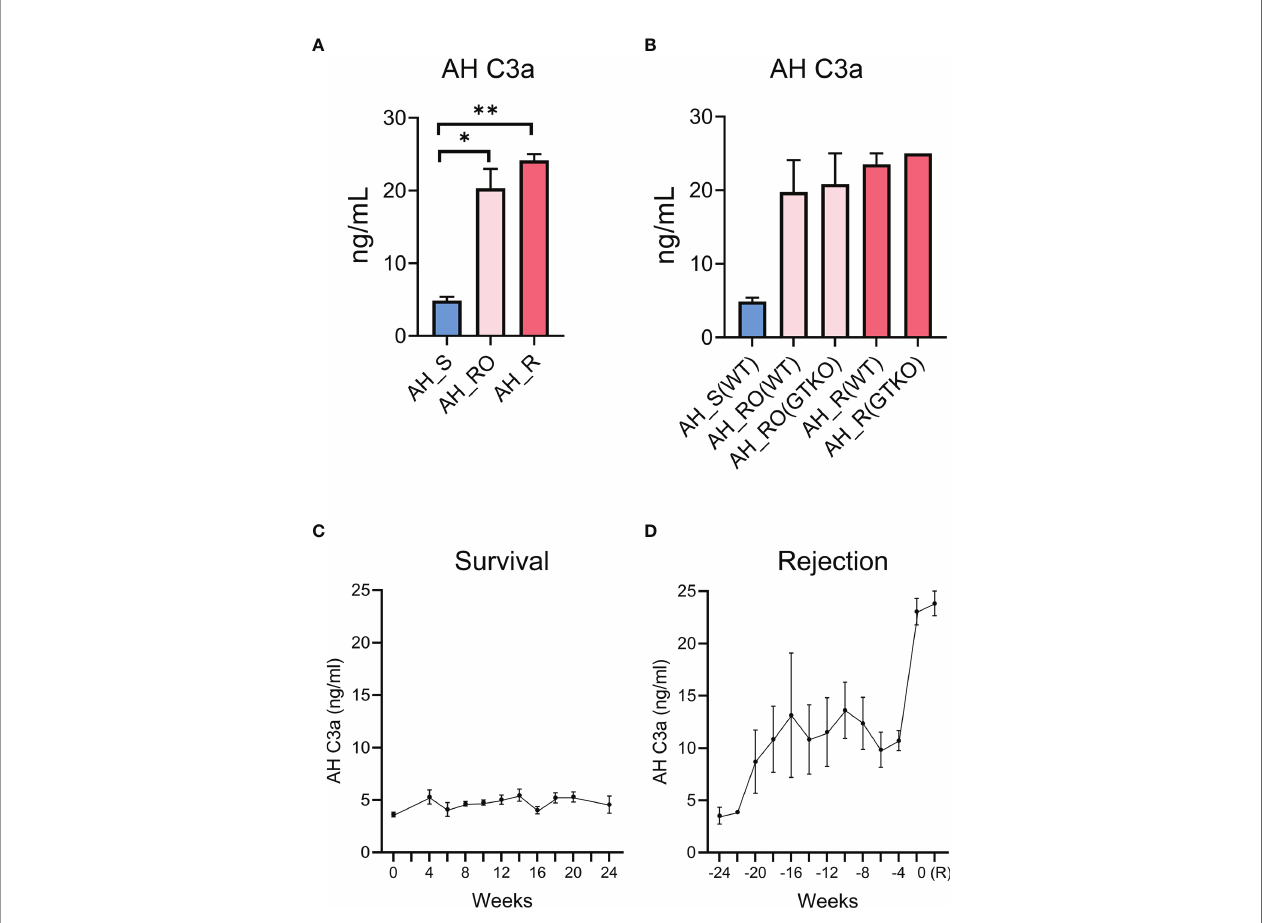
FIGURE 6 | Validation of aqueous humor (AH) C3a as a putative biomarker for corneal xenograft rejection. (A) Concentration of aqueous humor (AH) C3a in the survival (AH_S), rejection ongoing (AH_RO), and rejection (AH_R) groups. The concentration of AH C3a was signi fi cantly higher in the rejection ongoing (RO) and rejection (R) groups compared with that in the survival (S) group ( p = 0.034 and p = 0.002; Kruskal – Wallis test with Dunn ’ s multiple comparisons test). (B) Subgroup analysis of the concentration of AH C3a. AH_RO(WT) and AH_RO(GTKO) mean the AH of the RO subgroup transplanted with wild type (WT) and a -1,3 ‐ galactosyltransferase gene ‐ knockout (GTKO) porcine cornea, respectively. AH_R(WT) and AH_R(GTKO) mean the AH of the R subgroup transplanted with WT and GTKO porcine cornea, respectively. The concentration did not differ according to the type of donor cornea (WT versus GTKO). (C) Time-dependent changes of AH C3a concentration in the survival group after xenotransplantation. The time point of xenotransplantation was set as the reference time point (0 week). (D) Time- dependent changes of AH C3a concentration in the rejection group after xenotransplantation. The time point at which xenograft rejection was set as the reference time point (0 week) and the AH C3a concentrations before rejection were shown. R, rejection. Data are presented as means ± standard error. * p < 0.05, ** p <